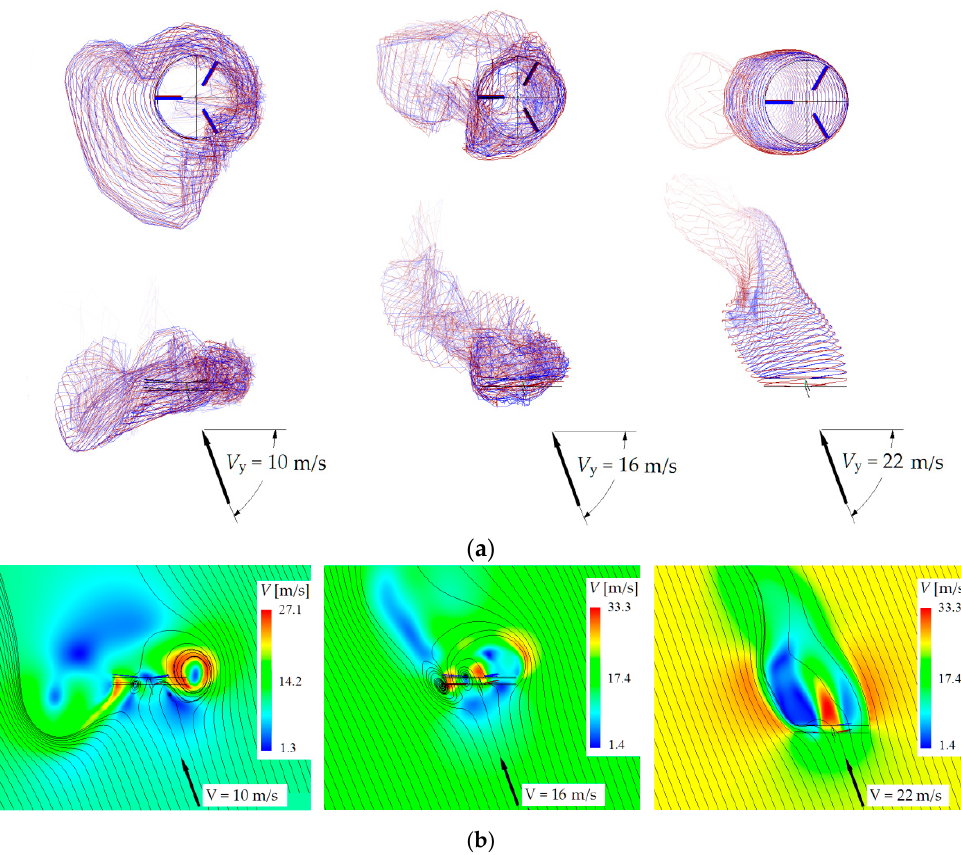
Figure 5. Free vortex wake shapes ( a ) and flow ( b ) around the rotor visualization at α R = 70°.